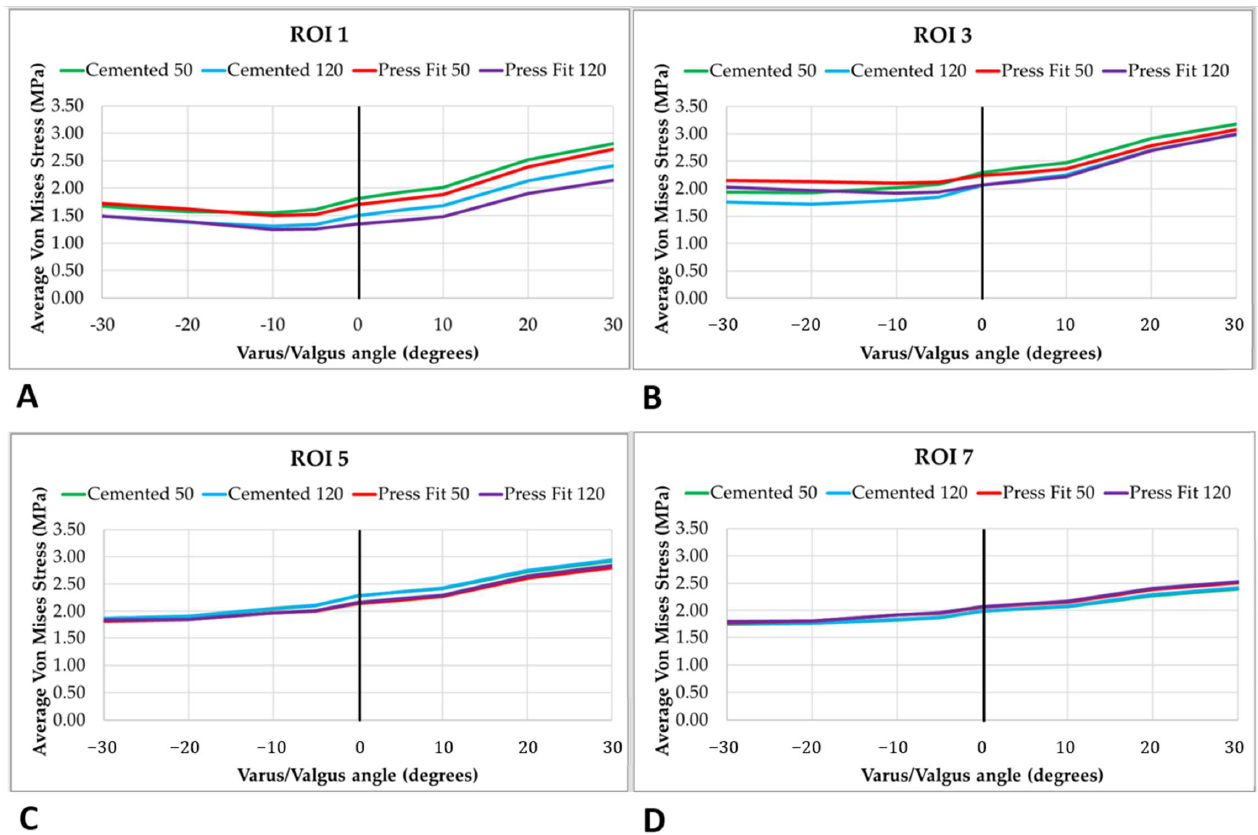
Figure 5. Average von Mises stresses in four regions of interest (( A ): ROI 1, ( B ): ROI 3, ( C ): ROI 5, ( D ): ROI 7) for the different prosthesis features, according to the varus/valgus angles addressed. The detailed values for the four different models are reported in Tables 6–9. Table 6. Average von Mises stresses (in MPa) in the different ROIs for the 50 mm press-fit stem. Configuration